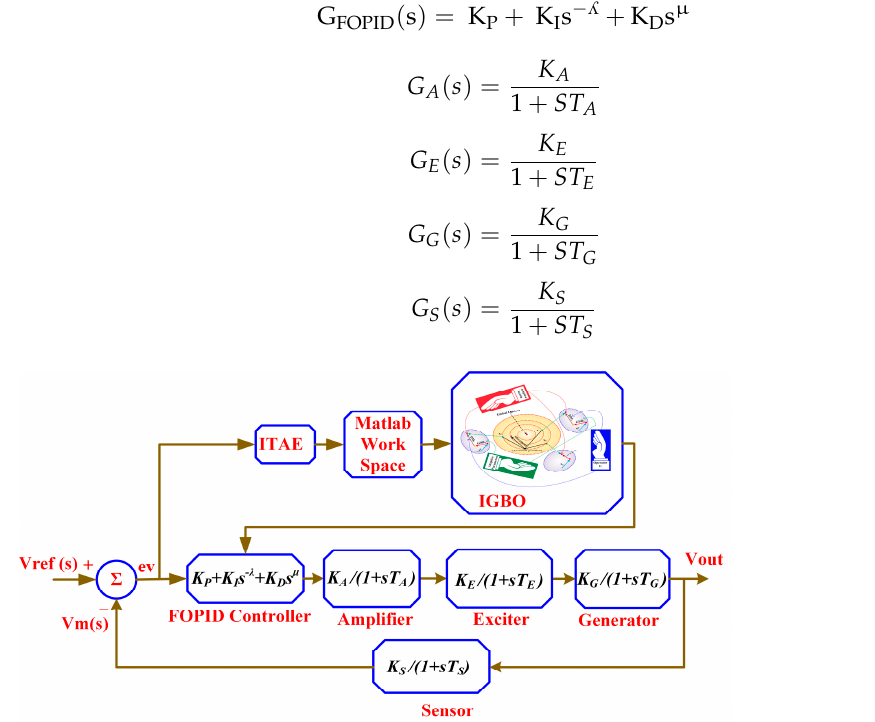
Figure 4. IGBO-based FOPID-AVR FOPID controller.